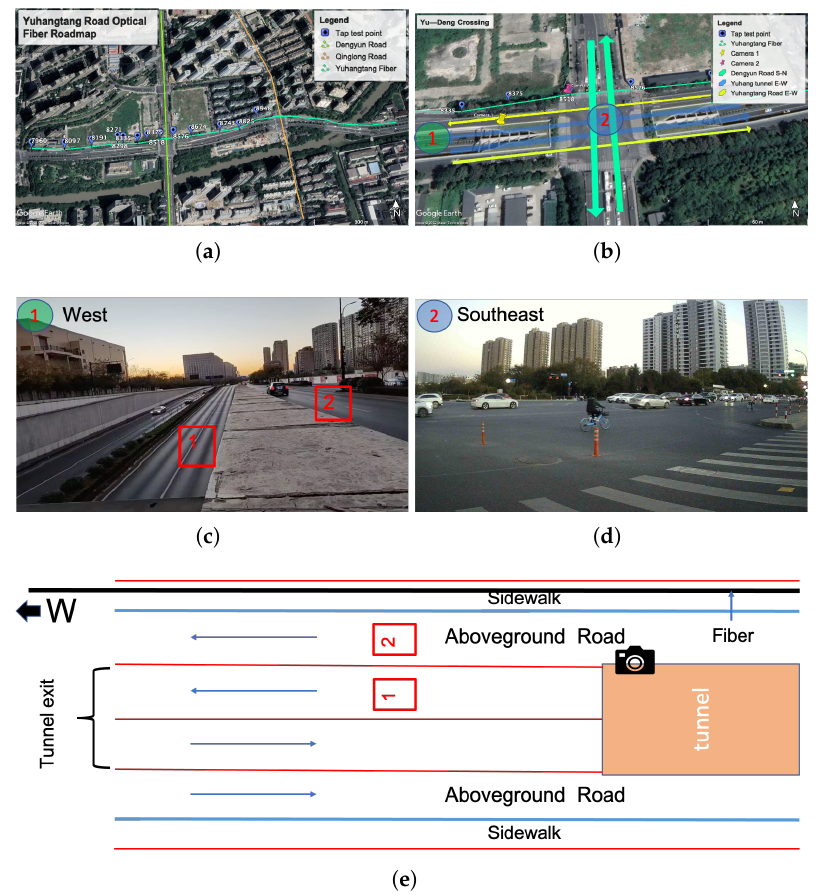
Figure 4. ( a ) Google satellite imagery showing the road section analyzed in detail in this study. ( b ) A zoom-in plot of the intersection that is monitored by two video cameras (yellow and red pins). The arrow indicates the traffic flow directions. ( c ) The tunnel exit is monitored by camera 1 facing the west direction. ( d ) The intersection is monitored by camera 2 facing the southeast direction. ( e ) A diagram illustrates the road layout of the monitored area of camera